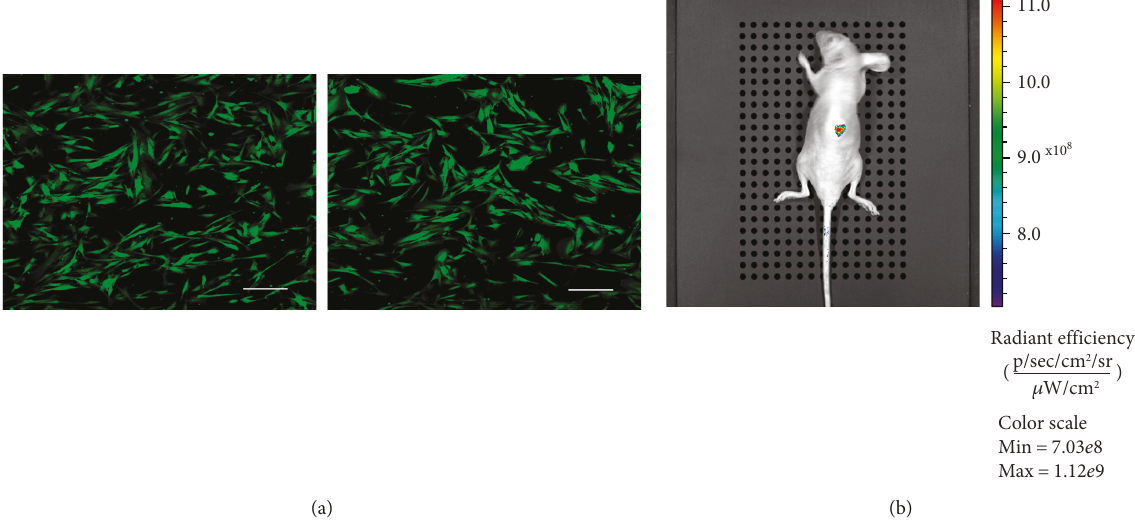
Figure 5: Potential applications of SHED-Bmi1-EGFP. (a) SHED-Bmi1-EGFP were seeded in zein/gelatine sca ff olds and were observed with a confocal microscope. Scale bar, 200 μ m. (b) SHED-Bmi1-EGFP were injected on the backs of nude mice, and EGFP signalling was detected by the Xenogen IVIS